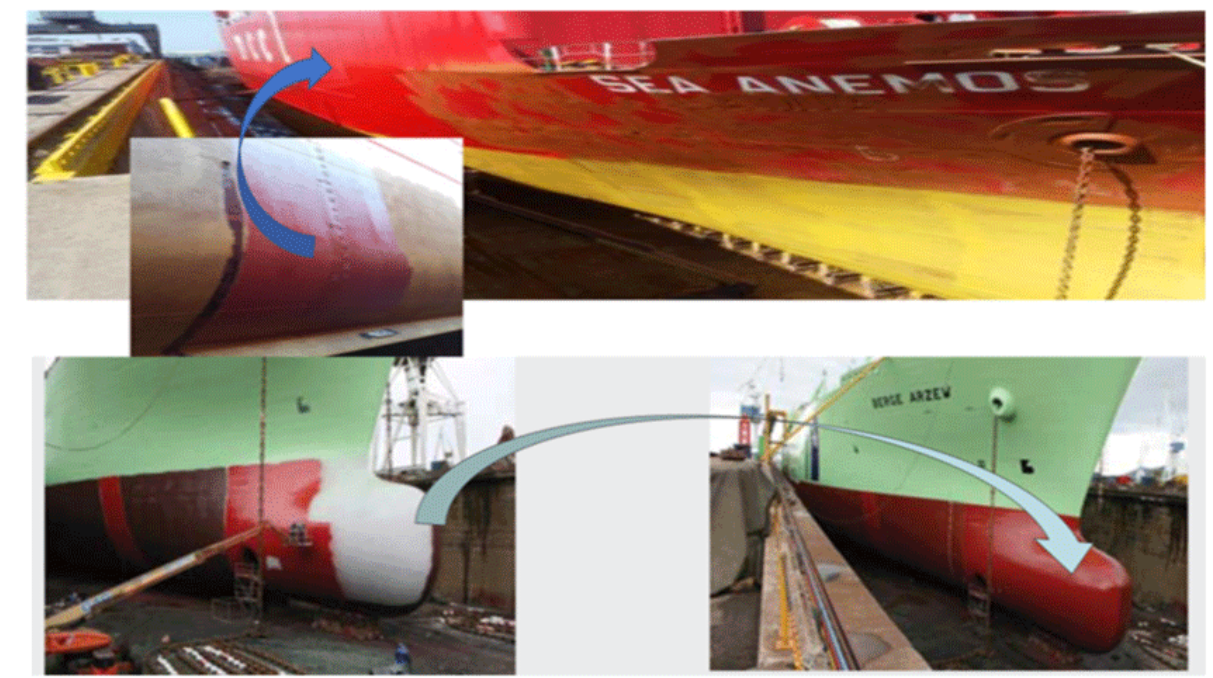
Figure 7. The segments of the two ships painted by our nanotechnology.